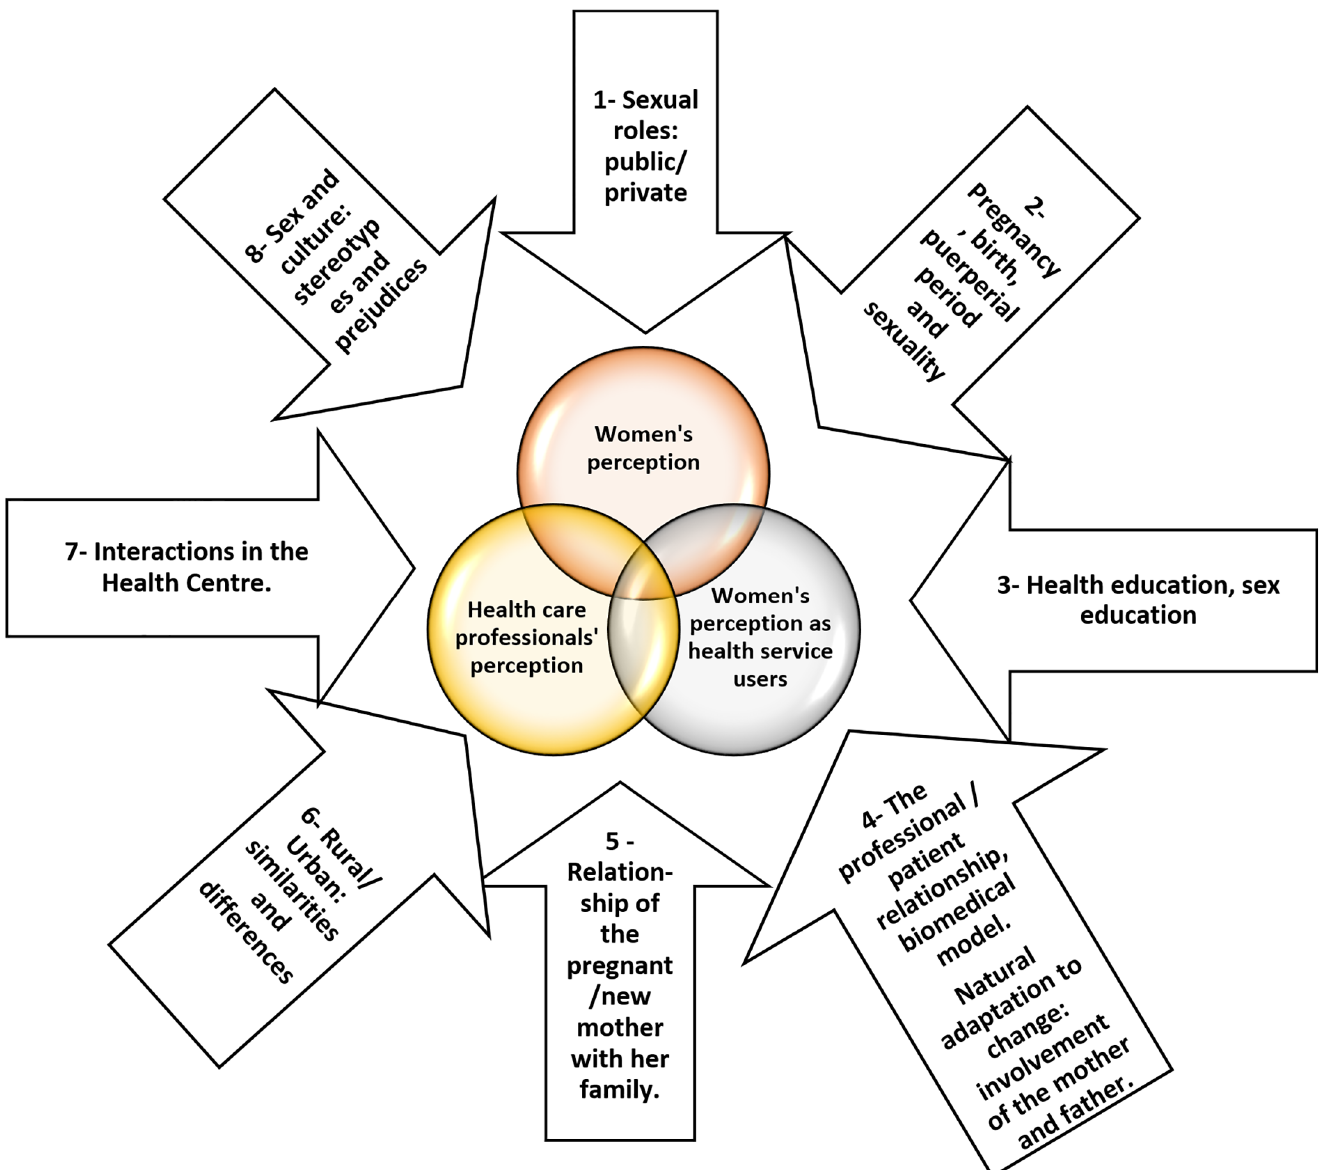
Fig 3. Graphic representation of meta-categories/qualitative vectors. Source: Created by the